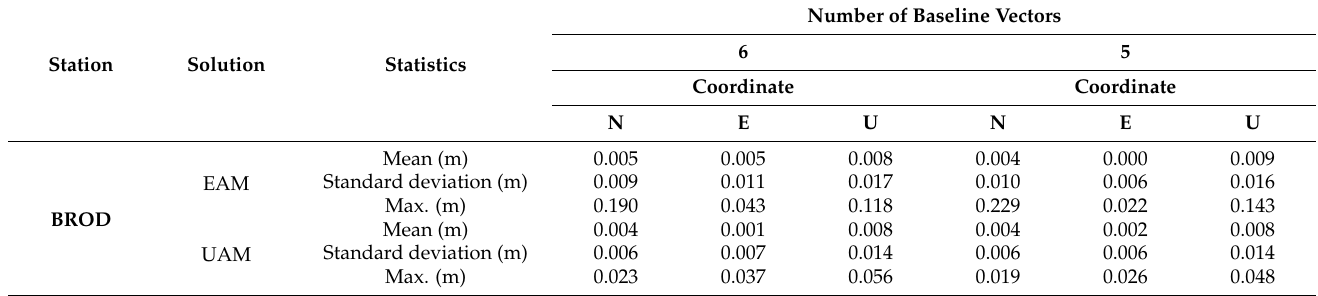
Table 2. Mean discrepancies with respect to reference coordinates, their standard deviation, and extreme values obtained with the EAM and UAM for six and five baseline